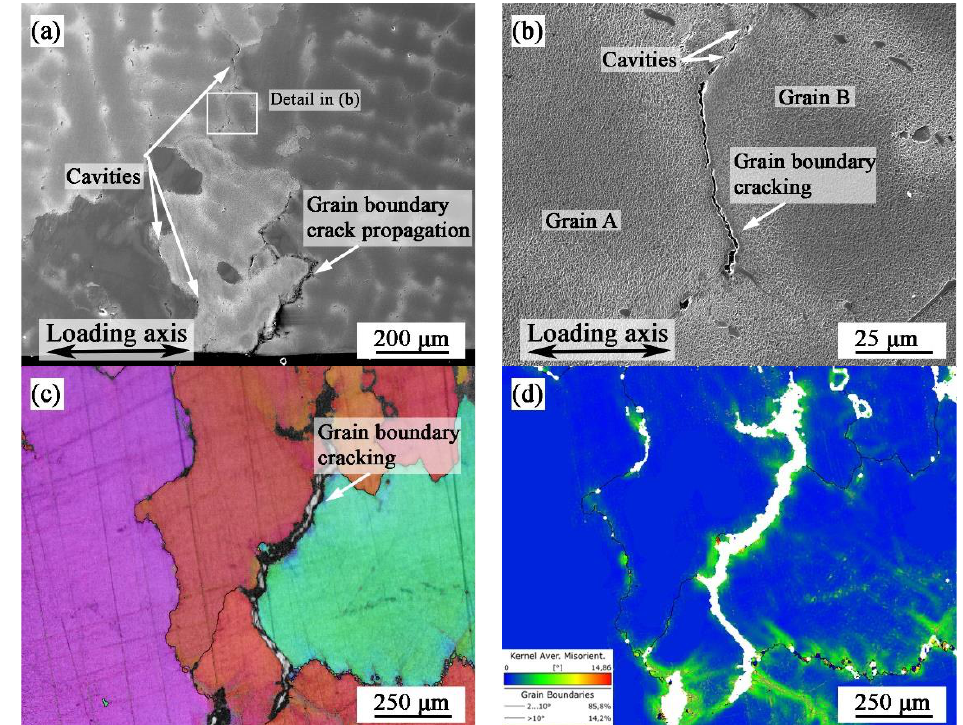
Figure 8. Typical TMF damage under IP loading ( a ) fatigue crack initiation at the grain boundary and intergranular fatigue crack propagation ( b ) detail of internal grain boundary damage ( c ) post- processed EBSD map (band contrast + inverse pole figure coloring) of internal grain boundary damage ( d ) KAM map showing local grain misorientation derived from EBSD data.